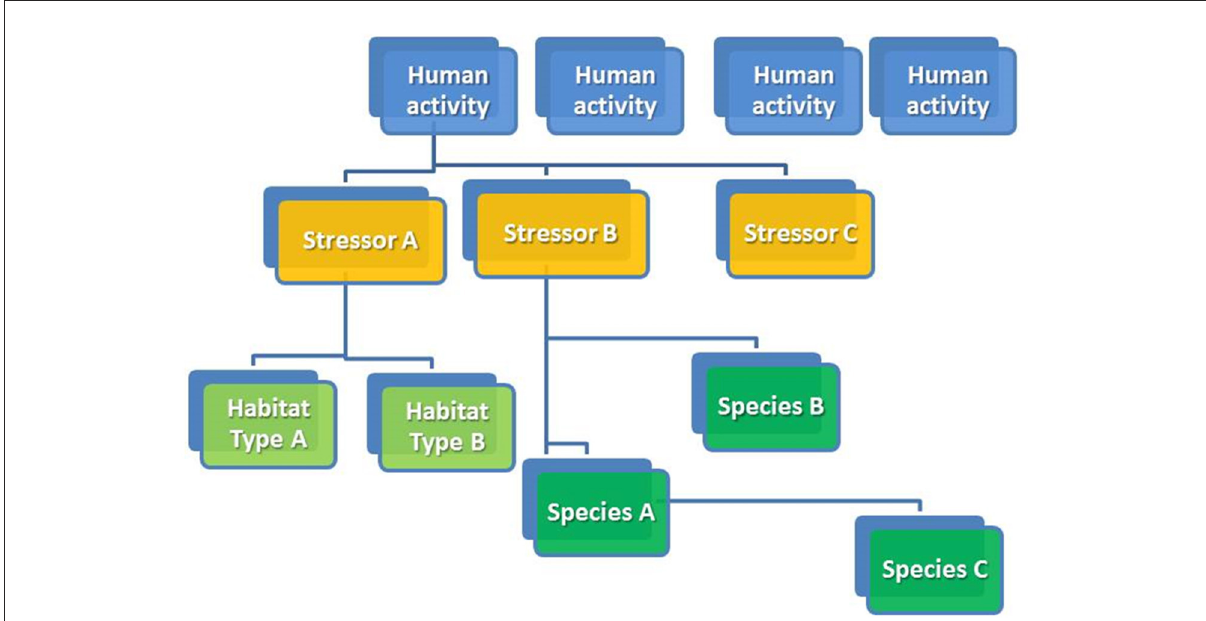
FIGURE3 Hypothetical pathways followed by cumulative effects from human activities on the ecological components of the system [Modified from Hodgson et al. (2019)].